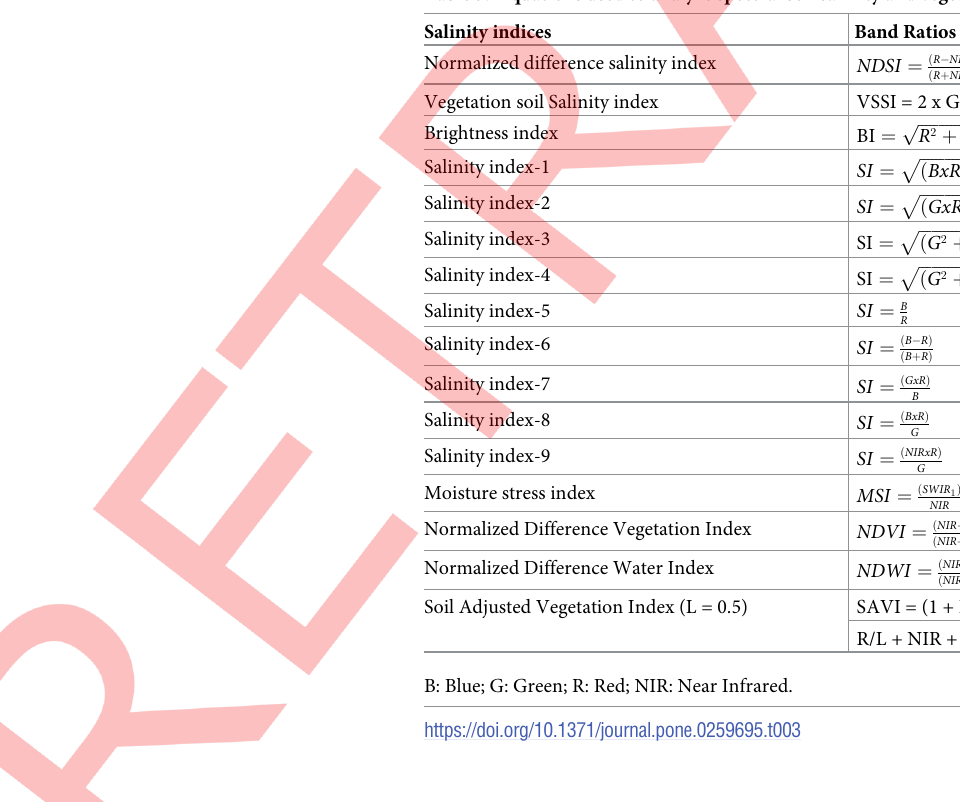
Table 2. Panchromatic, Cirrus and Thermal infrared bands were not used in the study. The buildings in the farmland were masked and excluded from the evaluation. The study area boundary map was subset with OLI image using the shape file, and the image was made ready for analysis in ERDAS-Imagine 1 (version 2014) software [36]. Some salinity and vegetation indices suggested in the literature were calculated to deter- mine and map the soil salinity following the necessary pre-processing of satellite images. The equations of the indices are given in Table 3. Spectral bands of OLI image and indices calcu- lated from the bands were opened in grid format in geographic information systems (GIS) and overlapped with the coordinates of soil EC sampling points. The reflection values of the salinity